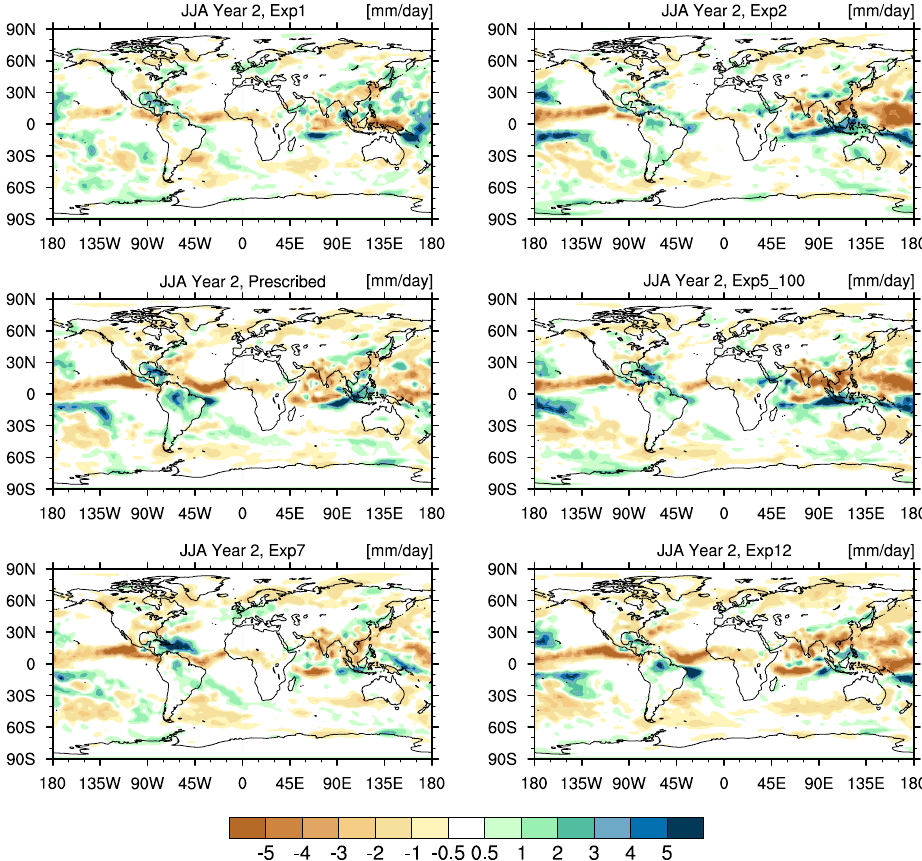
Fig. 11. Precipitation changes [ mmday − 1 ] averaged for June, July, and August of the second year following the soot injection for Exp1, Exp2, Prescribed, Exp5_100, Exp7, and